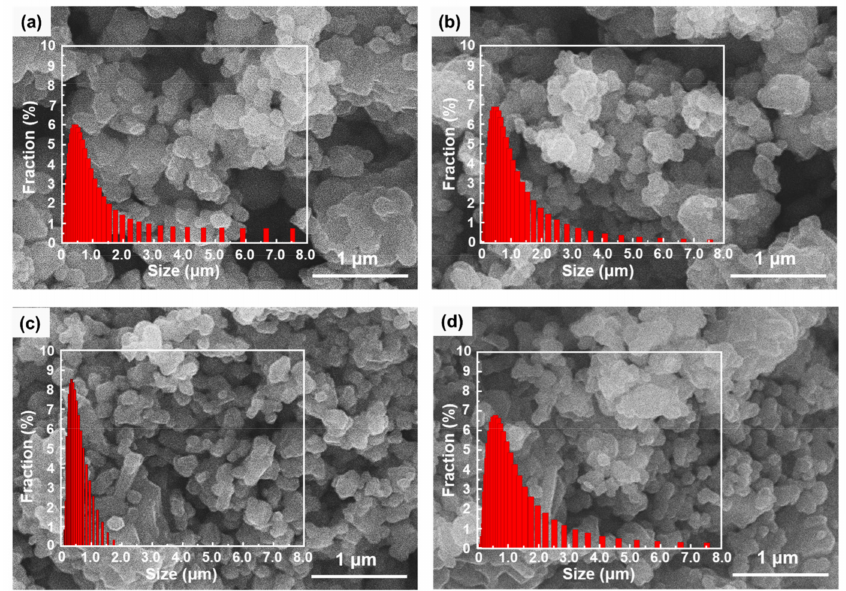
Figure 3. Morphology and particle size distribution of LNCM ( a ) without microwave irradiation, and with ( b ) 10, ( c ) 20, and ( d ) 30 min of microwave